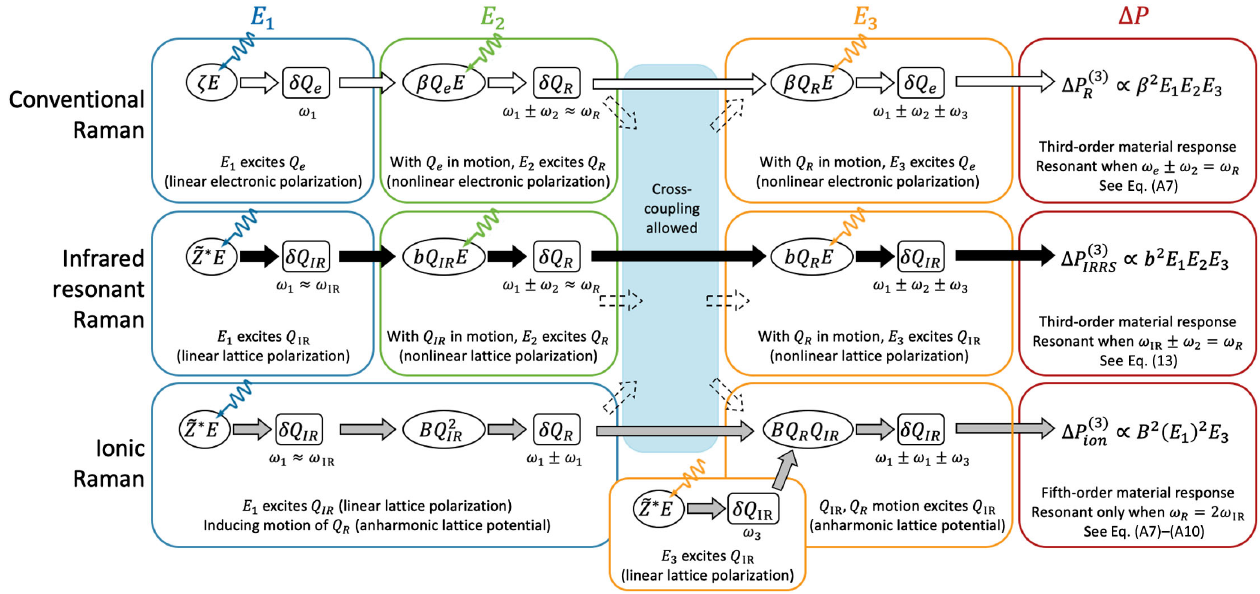
FIG. 2. Comparison between the conventional (top), infrared-resonant (middle), and ionic Raman-scattering (bottom) mechanisms. Blue, green, and orange panels represent the effect of the three electric field components, while the induced polarization is shown in the red panels. Driving terms in Eq. (11) are shown in ovals with induced motion represented in rectangles with the allowed frequency response written below. The connection to linear and nonlinear polarization, and the anharmonic potential are shown in the text in each panel with resonance conditions for each effect called out in the polarization panels. Dashed arrows leading into the light-blue region in the middle of the figure show that cross-coupling is allowed between all three effects. The conventional and infrared-resonant Raman responses have potential for third-order resonance in the polarization [see Eqs. (13) and (A7) – (A10)], while ionic Raman scattering has potential for a fifth-order resonance [see Eqs. (A7) –